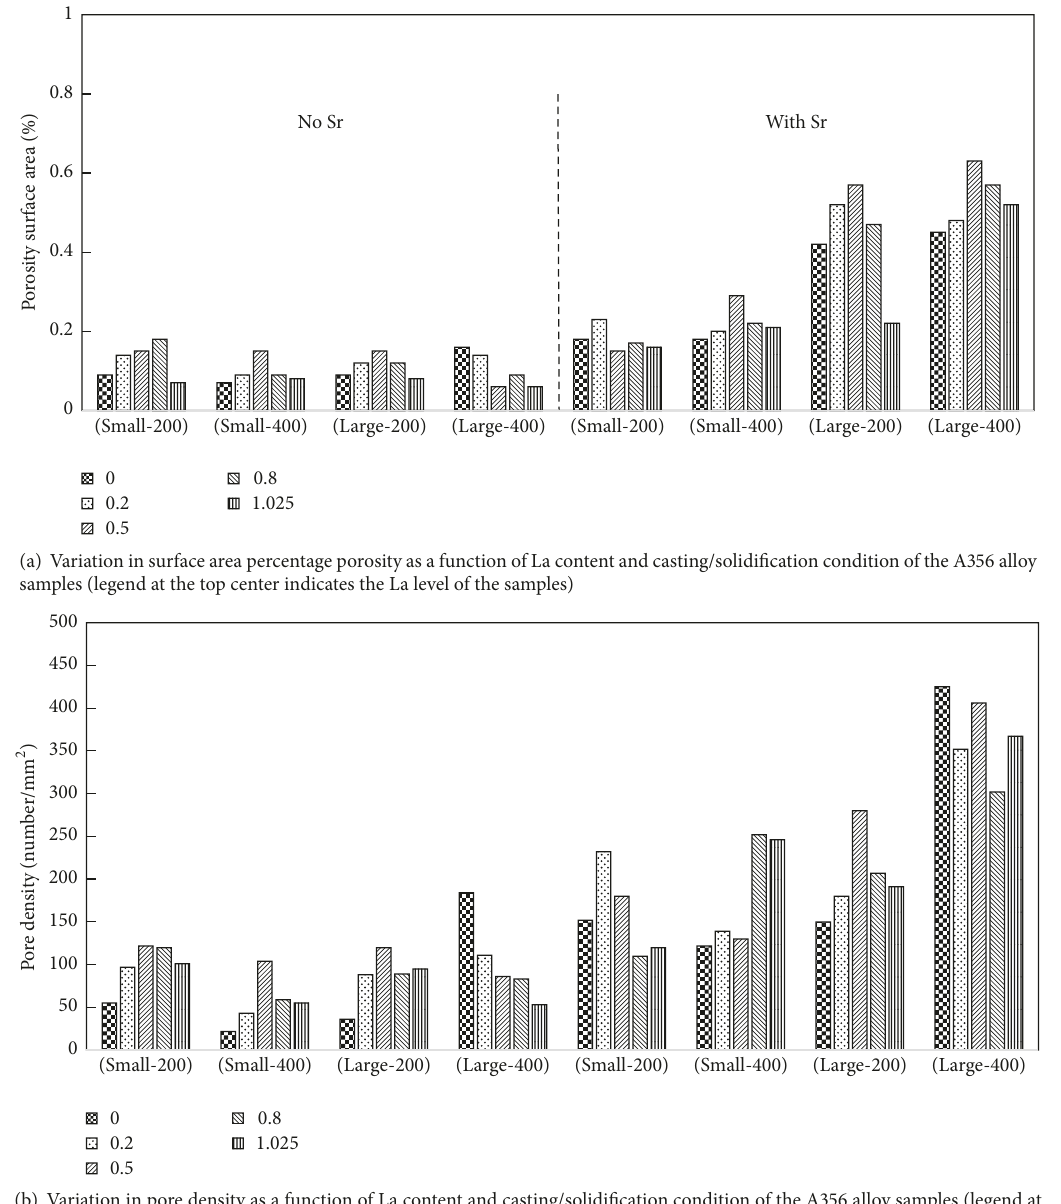
(7) The presence of traces of P observed in the A356 alloy samples leads to a reaction between P and Sr in the Sr-modified alloys, forming a complex compound which acts as a nucleation site for the precipitation of RE-rich phases.